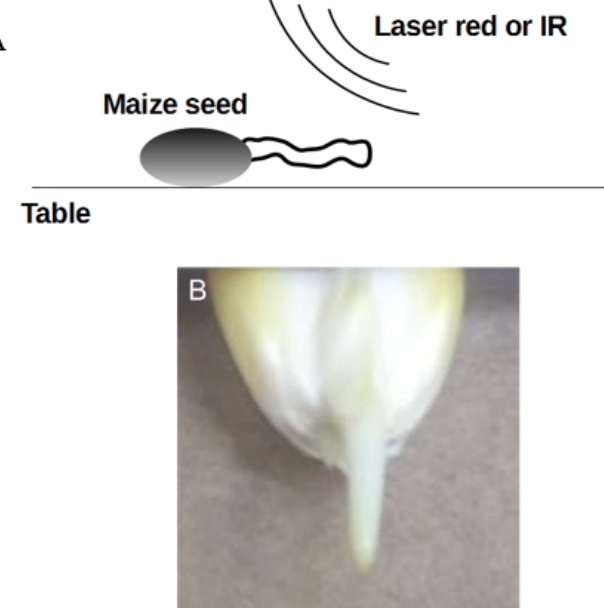
Figure 2. Seed imaging system. ( A ) Disposition of the seed on the table with a dry paper between them indicating the angle of the illumination with the cameras placed perpendicularly to the table and sample; ( B ) example of image obtained from a maize seed image without laser illumination.